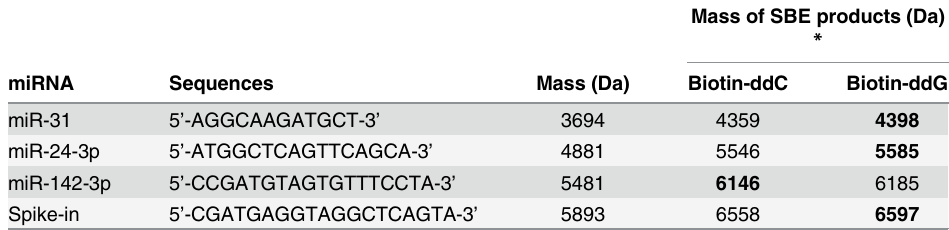
Table 2. SBE (Single Base Extension)